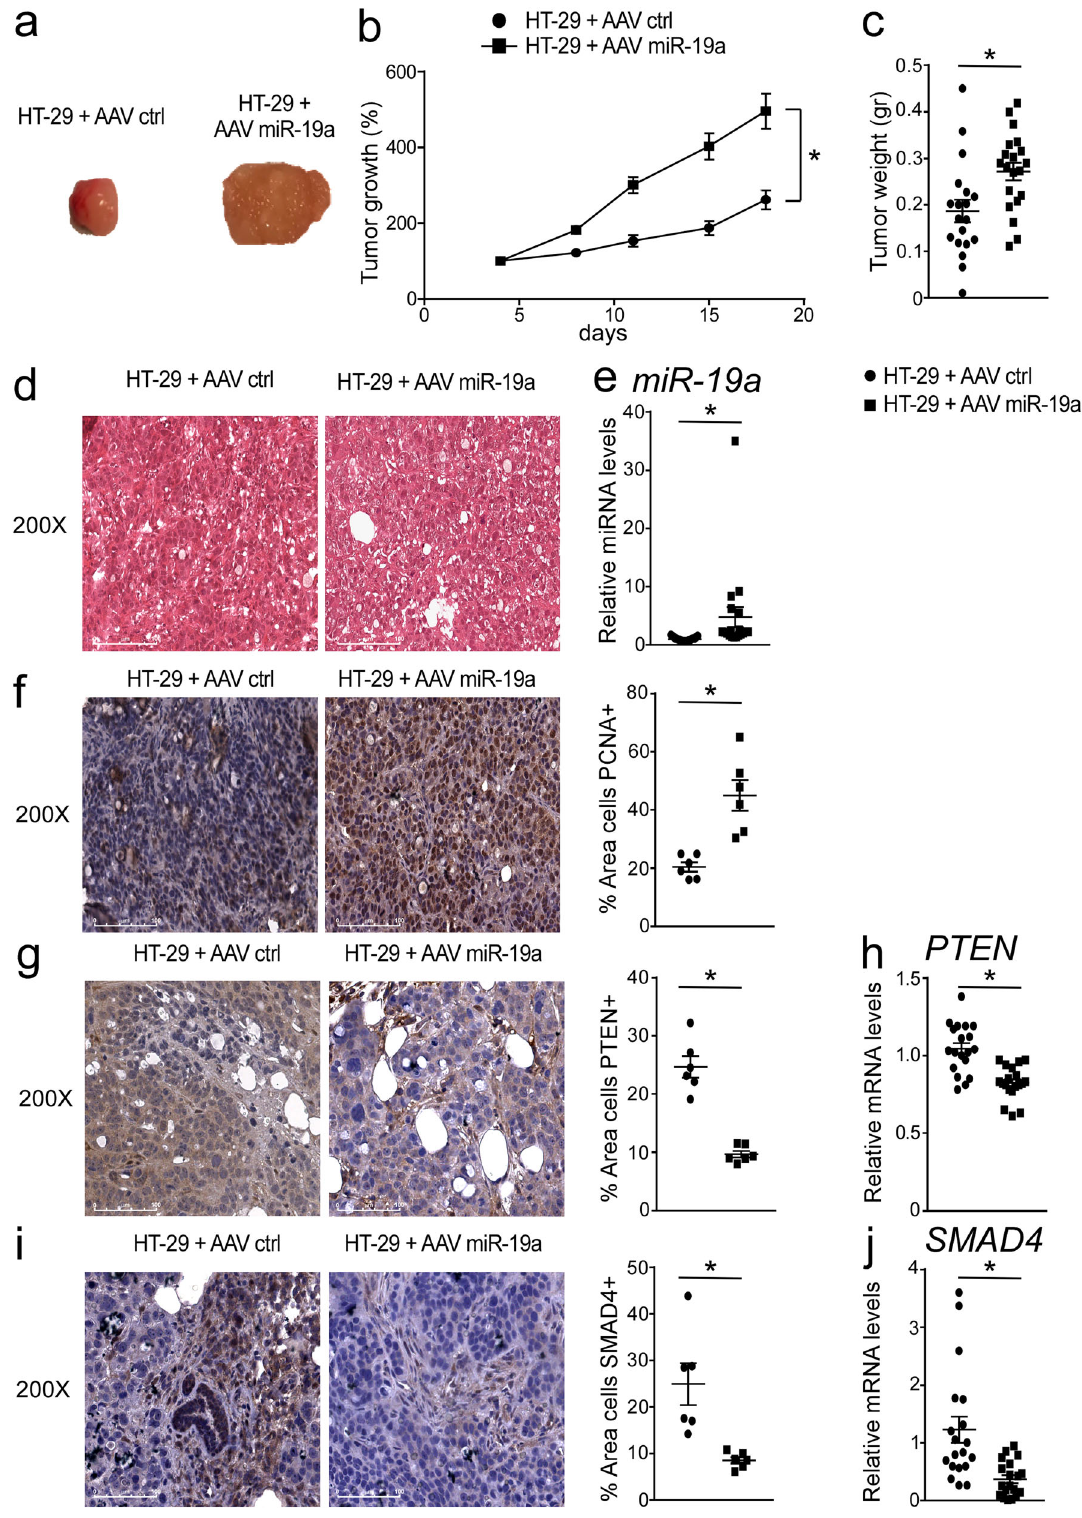
platelets in the intestinal tumor microenvironment driving colon cancer promoting scenario in visceral obesity. Moreover, the identi fi cation of tumor-promoting miR-19a as one of the relevant miRNA expressed in platelets elects platelet-speci fi c miRNome as a putative novel bona fi de strategy to prevent the development and/or to modify the prognosis of colon